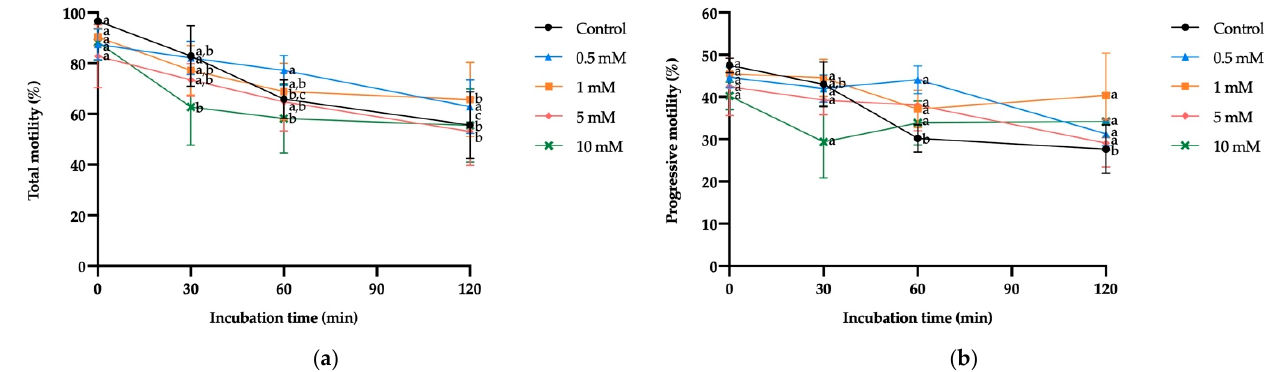
Figure 4. Mean ± SEM of total ( a ) and progressive ( b ) motility of donkey sperm exposed to oxidative stress with different hydrogen peroxide (H 2 O 2 ) concentrations measured at different incubation times. No significant differences were found between H 2 O 2 concentrations within a given incubation time. ( a , b ) Different letters indicate significant differences ( p ≤ 0.05) between incubation times within a given H 2 O 2 concentration.